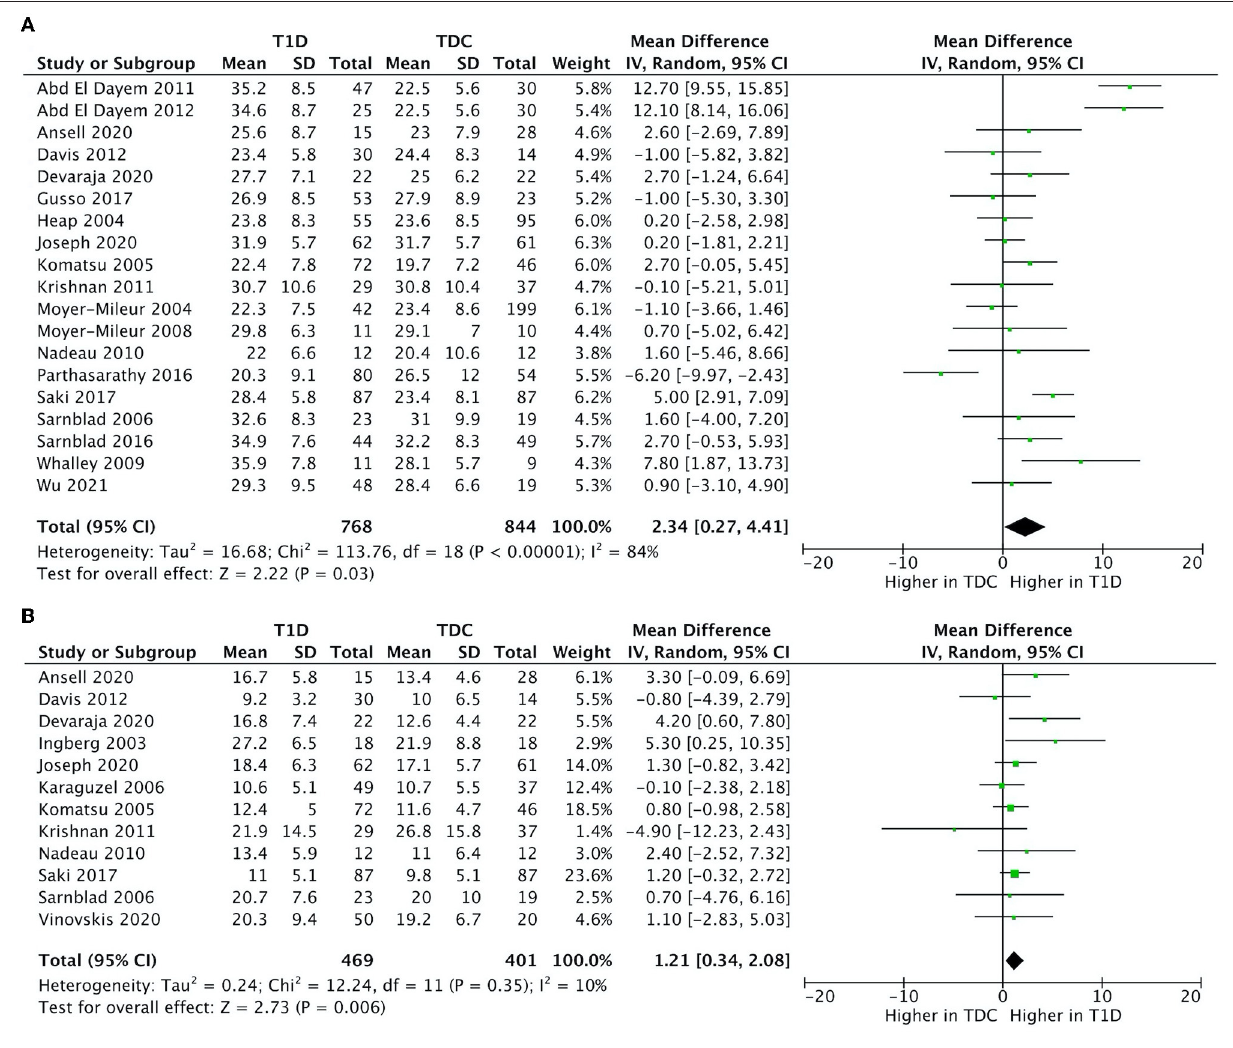
FIGURE 2 | Forest plots illustrating pooled analyses of mean difference of (A) fat mass (kg); and (B) body fat % compared children with T1D to TDC, with upper and lower limits showing 95% confidence intervals. BMI, HbA1c, and disease duration did not explain variance in body fat % mean difference ( p > 0.05) ( Supplementary Table 6